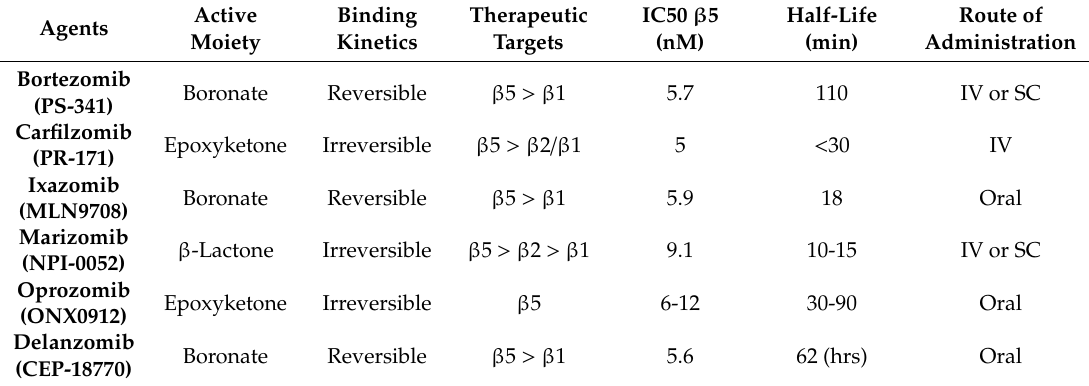
Table 1. Chemical and pharmacological features of di ff erent proteasome